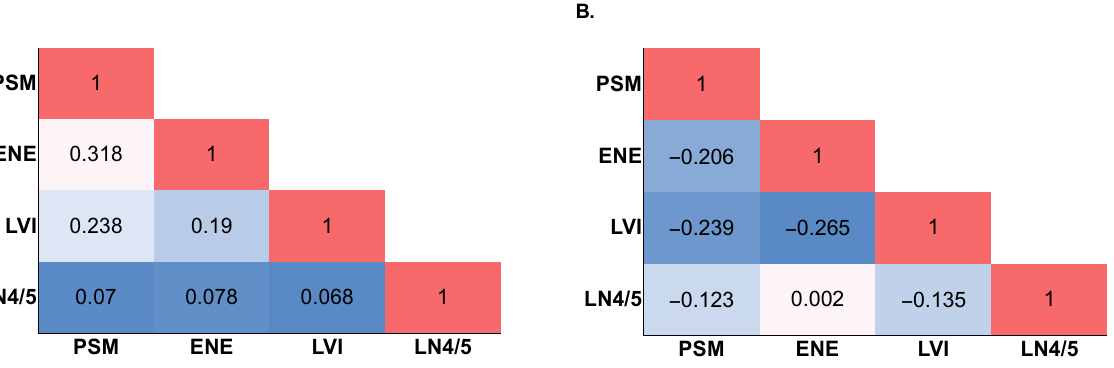
Of the total population of patients with HPV ‐ OPC, 8375 (55.4%) were positive for at least one AF, 6661 (44%) were negative for any AF, and 74 (0.5%) had unknown AF status. More AF ‐ positive patients were male (84.5% vs. 82.3%, p < 0.001), had palatine tonsil pri ‐ status. More AF-positive patients were male (84.5% vs. 82.3%, p < 0.001), had palatine mary (72.6% vs. 70.4%, p = 0.002), had more advanced primary tumor category (T2: 48.4% tonsil primary (72.6% vs. 70.4%, p = 0.002), had more advanced primary tumor category vs. 43%, p < 0.001), and more advanced lymph node disease (N3: 4.1% vs. 1.5%, p < 0.001). (T2: 48.4% vs. 43%, p < 0.001), and more advanced lymph node disease (N3: 4.1% vs. 1.5%, No significant difference was observed in comorbidity score with regard to AF status ( p = p < 0.001). No significant difference was observed in comorbidity score with regard to AF 0.107) (Table 1). In the analytic cohort, tumors with any individual AF were positively status ( p = 0.107) (Table 1). In the analytic cohort, tumors with any individual AF were correlated with having co ‐ localization of other AFs (Figure 1A). positively correlated with having co-localization of other AFs (Figure 1A).